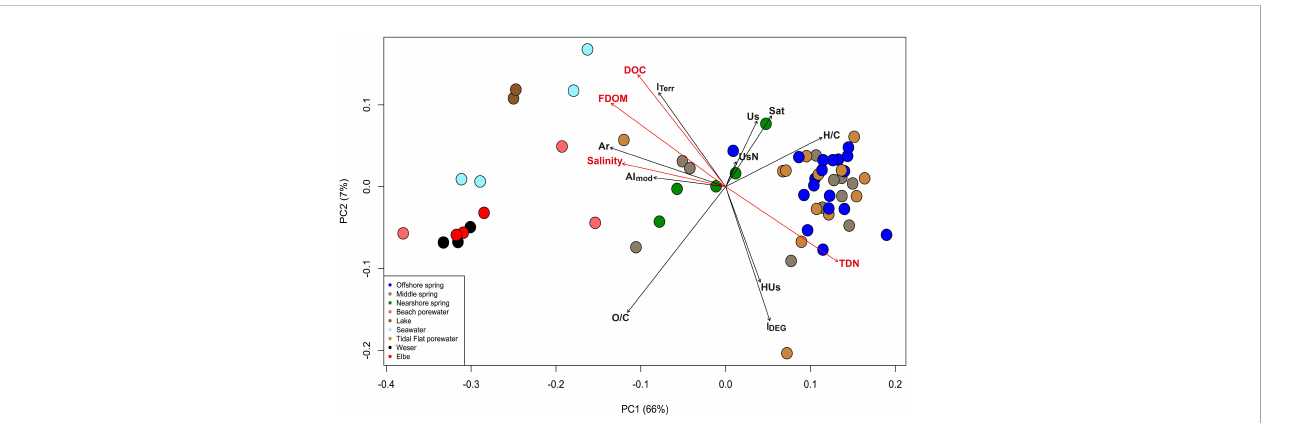
FIGURE 5 Principal coordinate analysis (PCoA) from February 2019 samples together with Weser and Elbe estuary samples from March 2019 based on Bray-Curtis dissimilarities of the relative abundance of FT-ICR-MS derived molecular formulae data. The percentages give the DOM molecular variability as explained by the PC1 and PC2 axes. Correlations of coordinates to molecular characteristics and environmental parameters were considered signi fi cant with p ≤ 0.05. Colors represent the sample